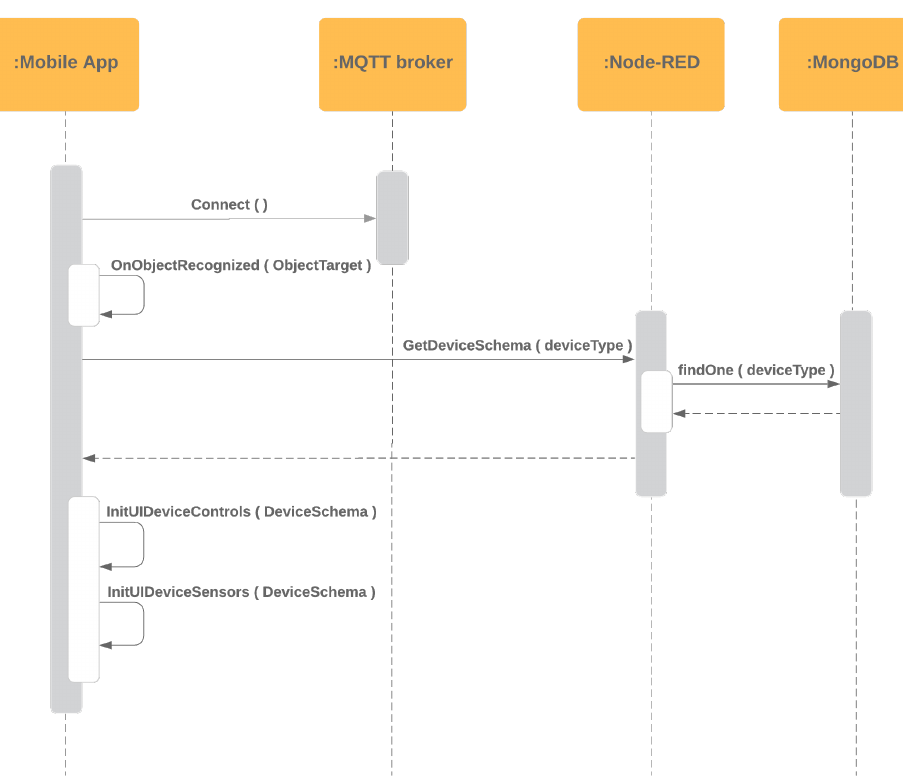
Figure 12. Sequence diagram: How a user interface is generated in Unity engine.